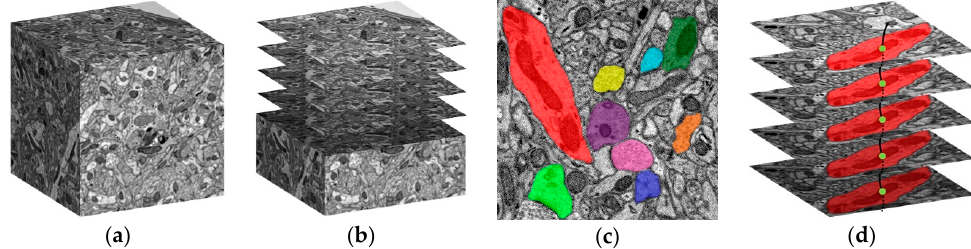
Figure 1. A schematic diagram of the sequential electron microscope images and the segmentation data that makes up a neuron. ( a ) A schematic diagram of the brain tissue block; ( b ) Sequential electron microscope (EM) images obtained from the brain tissue block; ( c ) Different colors represent different segments. Each segment represents a segmentation region of a neuron in the layer; ( d ) The segments on each layer form a neuron. Table 1. Reconstruction results over the years